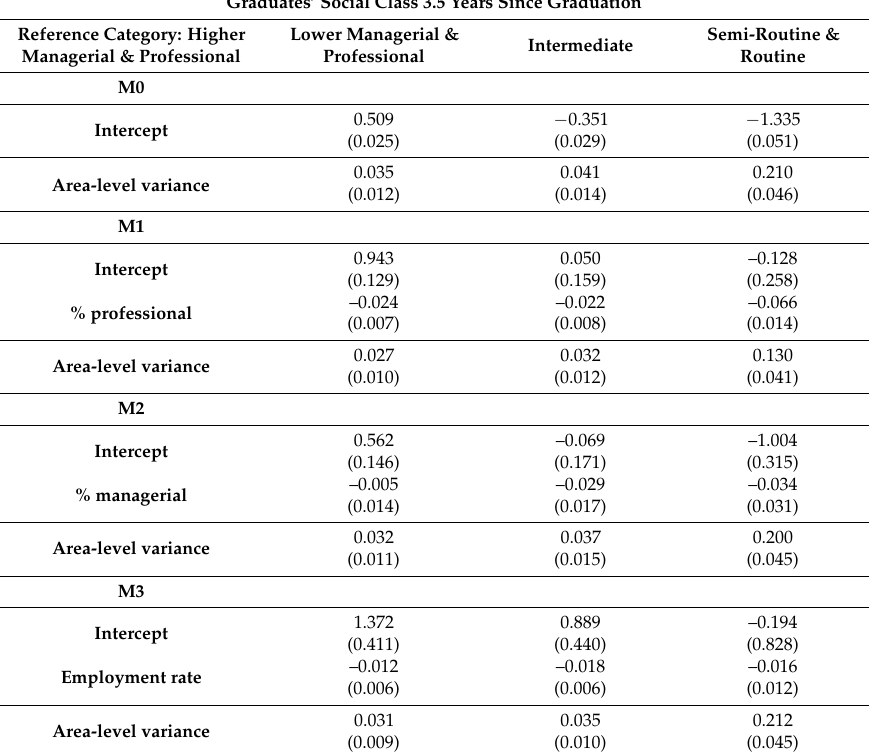
Table 1. Multilevel multinomial logit models estimating graduates’ probability of reaching different social classes 3.5 years since graduation vs. Higher managerial and professional social class (area-level variance, coefficients and standard